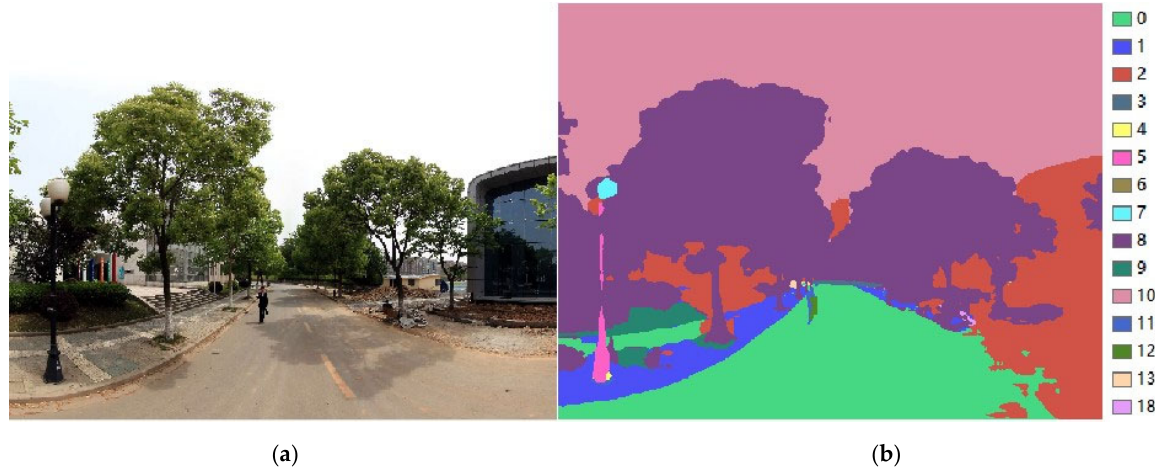
Figure 11. A sample of origin street view image ( a ) and the semantic segmentation result ( b ).